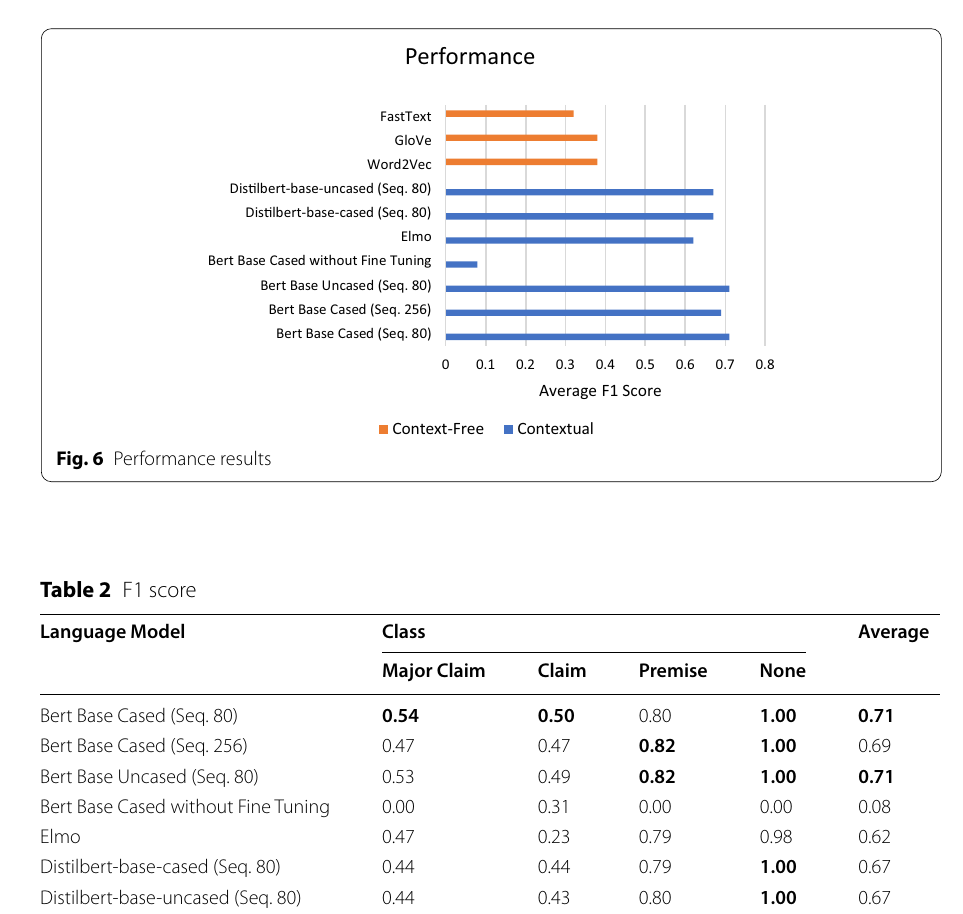
Bold emphasis data highlight the best performing model for each column